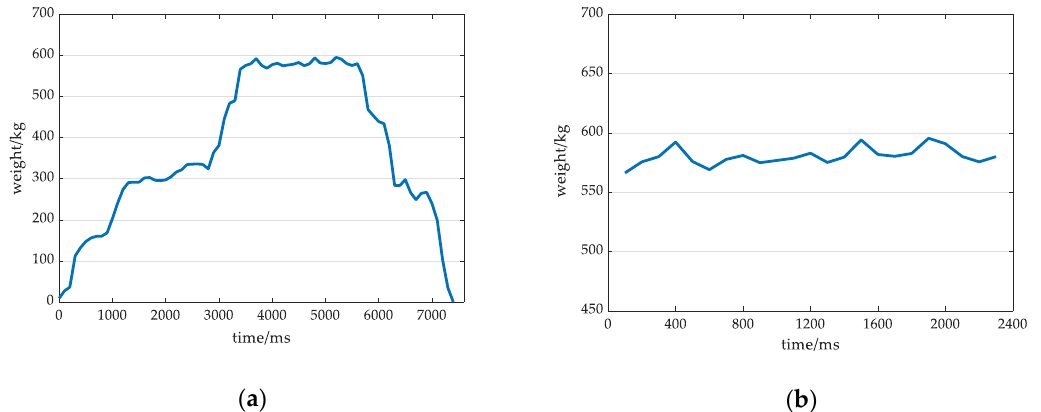
Figure 4. Original weight signal and valid signal under the slow grade of active degree conditions: ( a ) Original weight signal at a low grade; ( b ) Valid signal at a low grade.